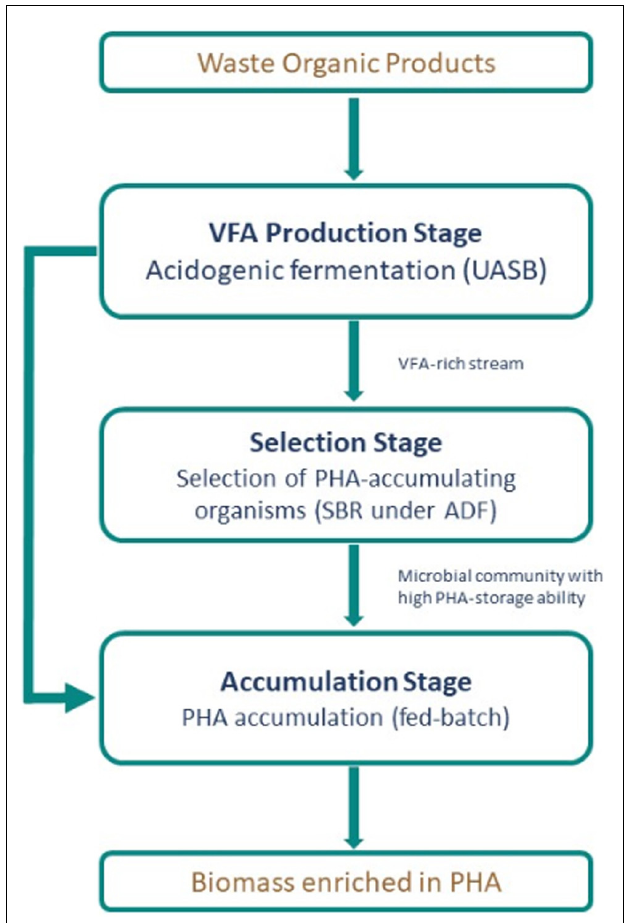
FIGURE 8 | Schematic representation of the PHA production process by mixed microbial cultures, using waste organic carbon as feedstock. VFA, volatile fatty acids; UASB, upflow anaerobic sludge blanket; SBR, sequencing batch reactor; ADF, aerobic dynamic